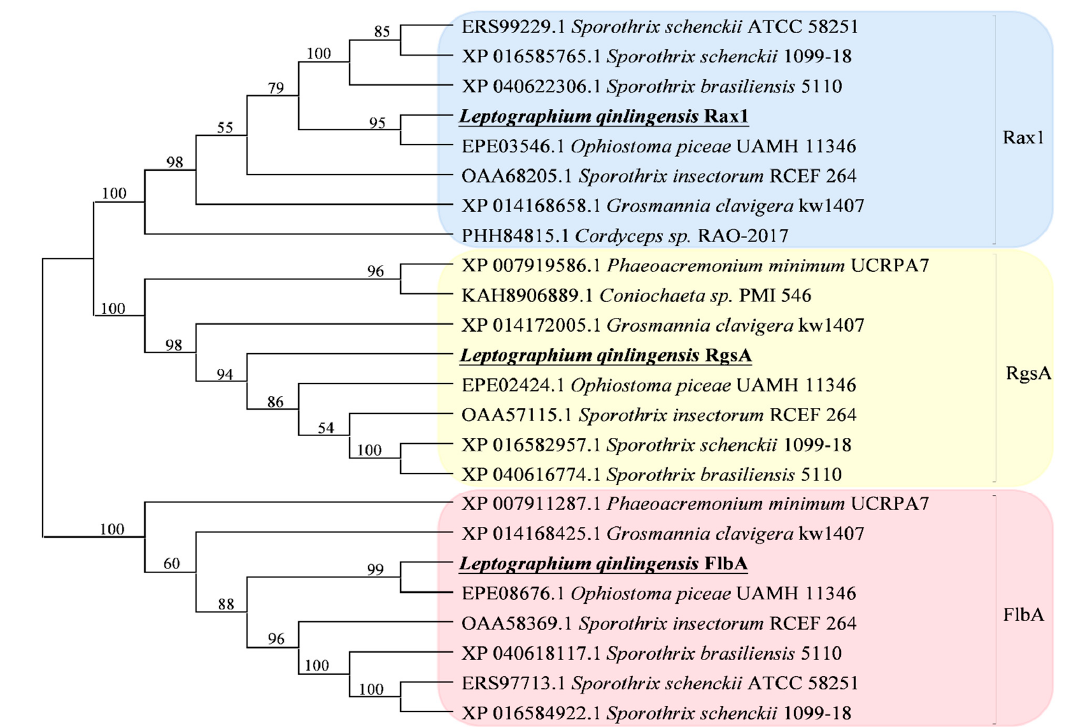
Figure 1. Phylogenetic tree of three regulators of G-protein signaling (RGS) from L. qinlingensis . The sequences from L. qinlingensis are marked in black. The phylogenetic tree was constructed with MEGA-X using the neighbor-joining method. Values indicated at the nodes are bootstrap values based on 1000 replicates.